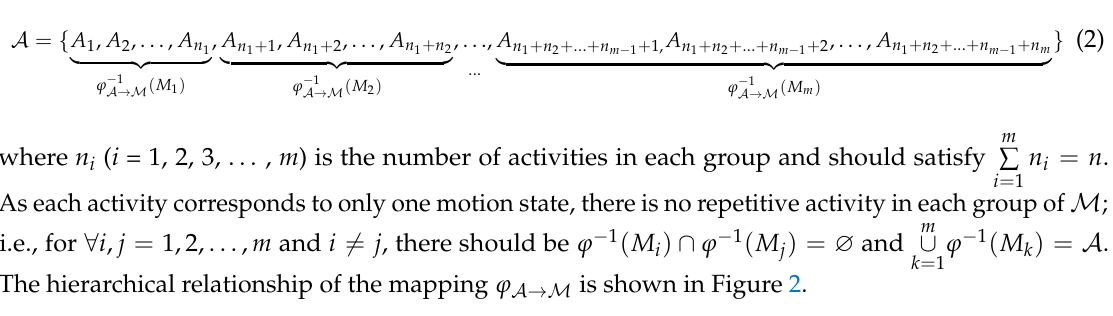
( b ) Figure 3. Hierarchical relationship of the correspondence ↔    defined by Equation (5).